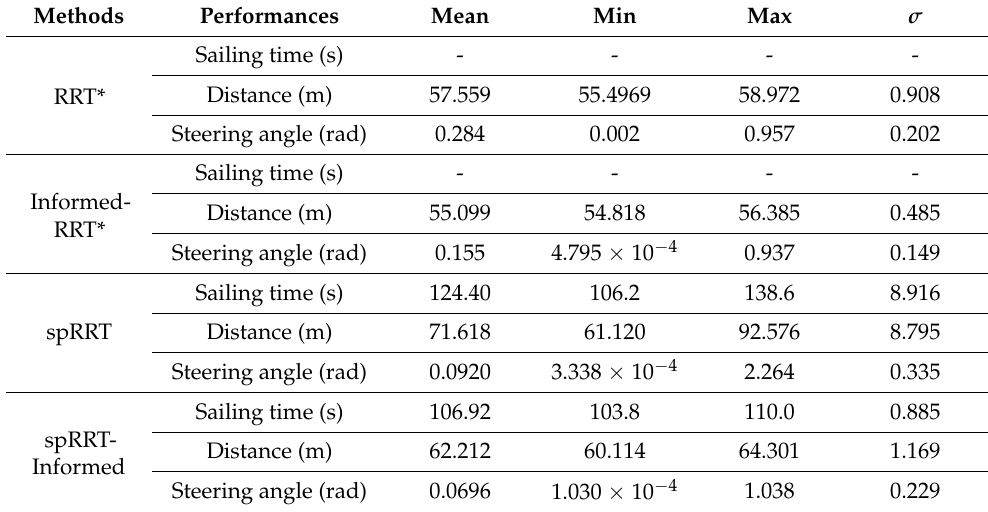
Table 2. Path characteristic parameters under scenario 1.